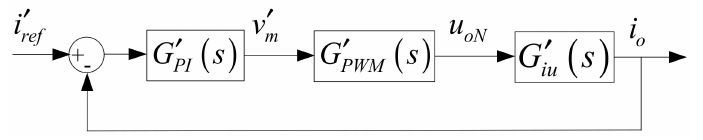
Figure 11. PR DC mode current control strategy.